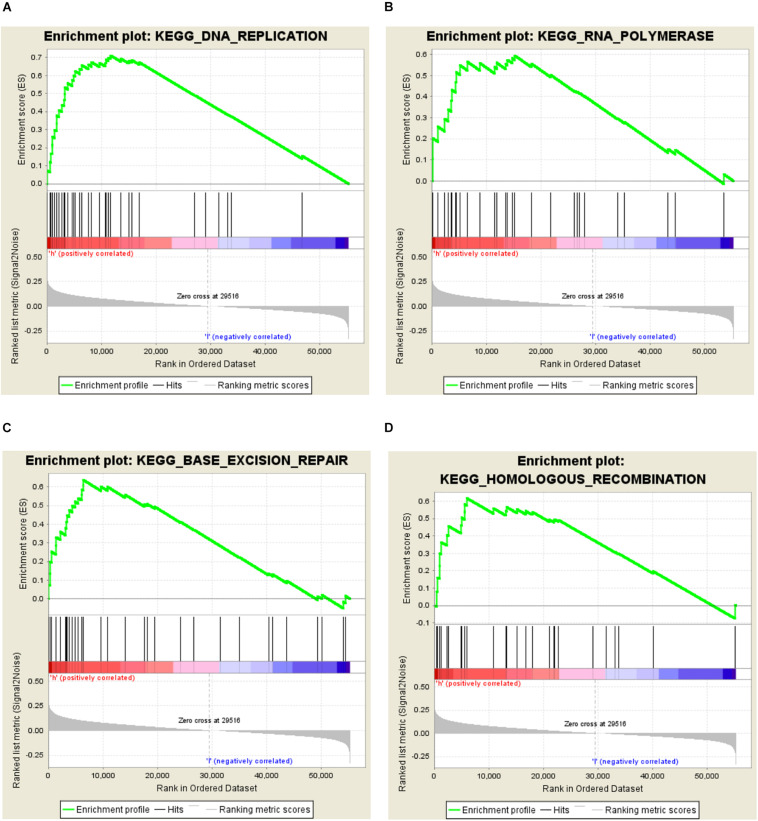
Enrichment plots from the Gene Set Enrichment Analysis (GSEA). GSEA results showing DNA replication (A), RNA polymerase (B), base excision repair (C), and homologous recombination (D) are differentially enriched in the CNTD2high expression phenotype.